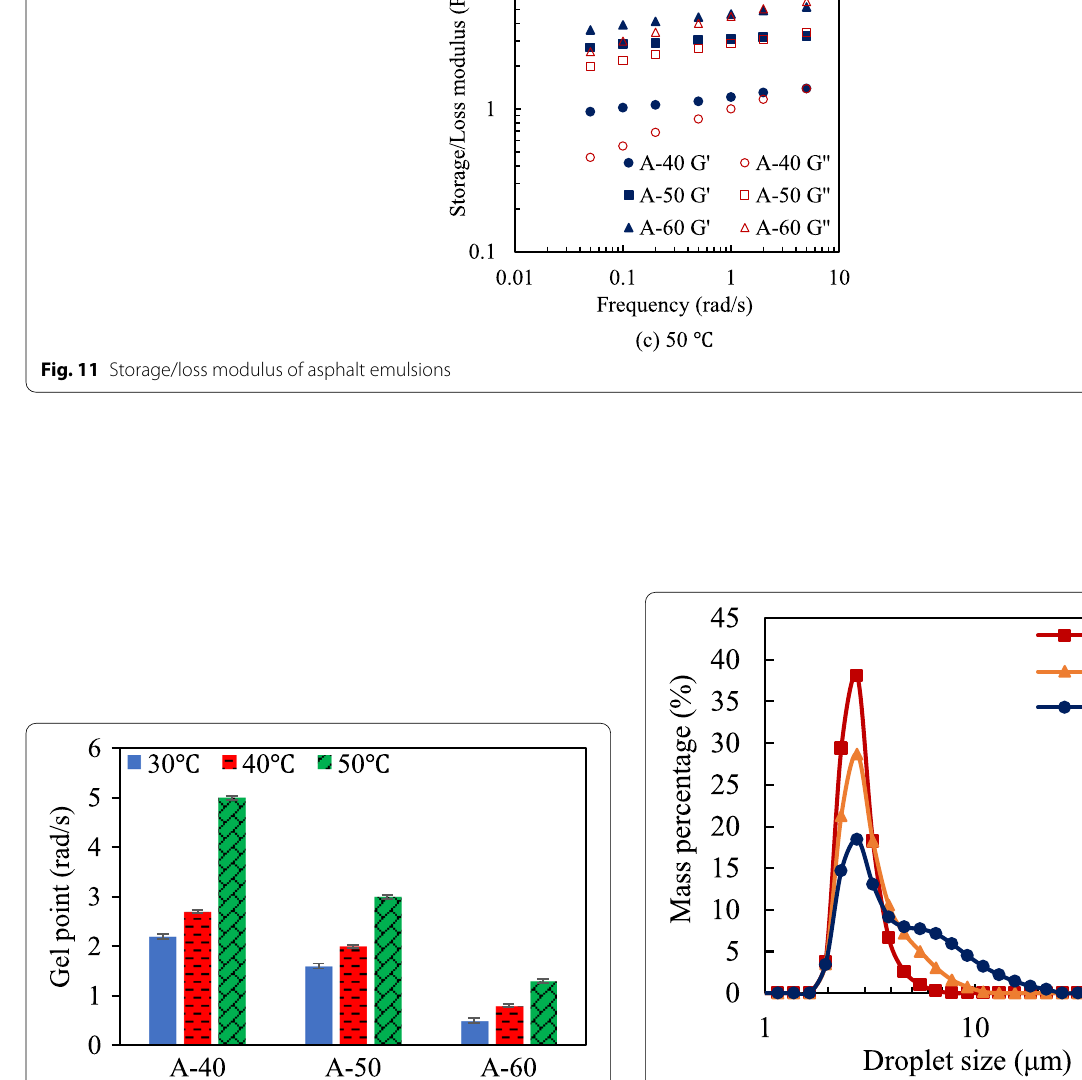
Fig. 12 Gel point of the studied asphalt emulsions Fig. 13 Droplet size distribution of the studied asphalt